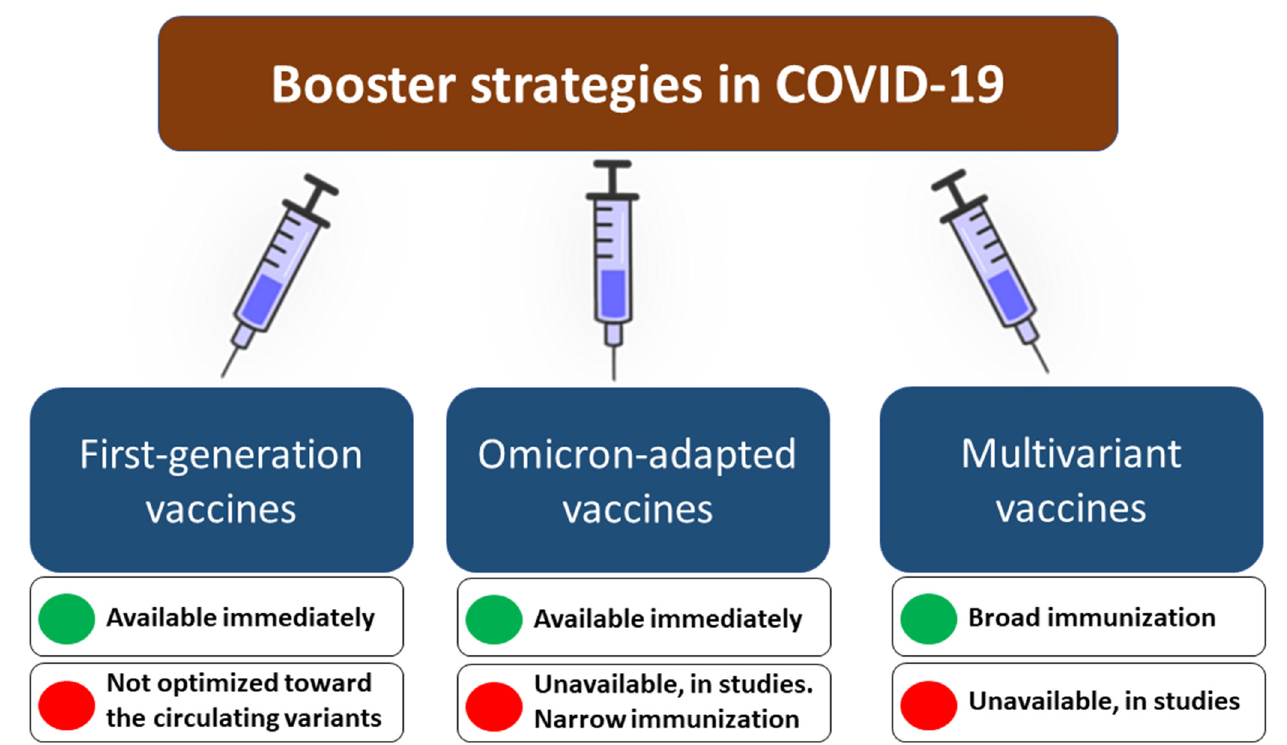
Figure 1. The potential booster vaccination strategies in COVID-19 to maintain high protection levels during future SARS-CoV-2 infection waves with their advantages and disadvantages.